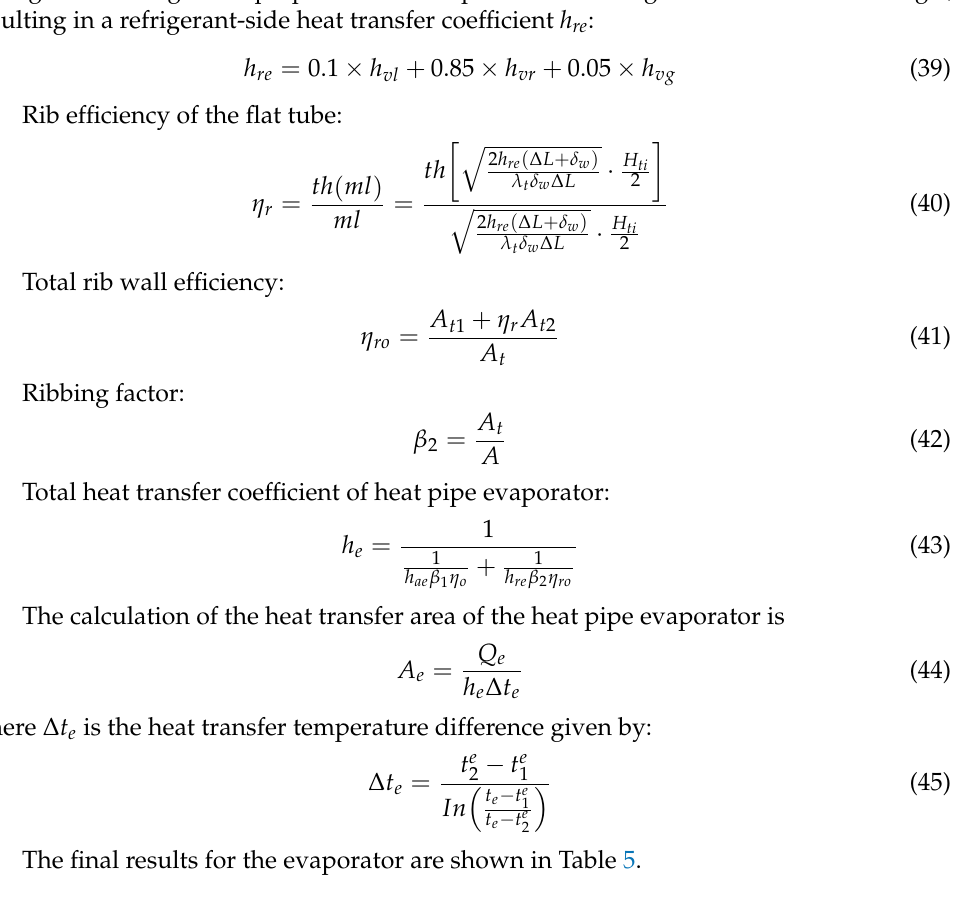
Table 5. Evaporator design